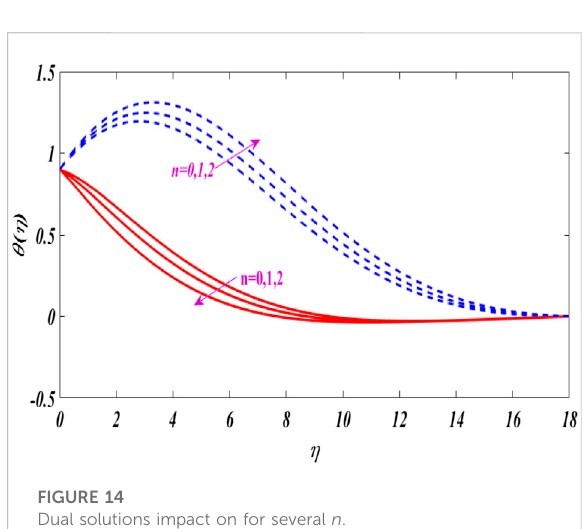
FIGURE 14 Dual solutions impact on for several n